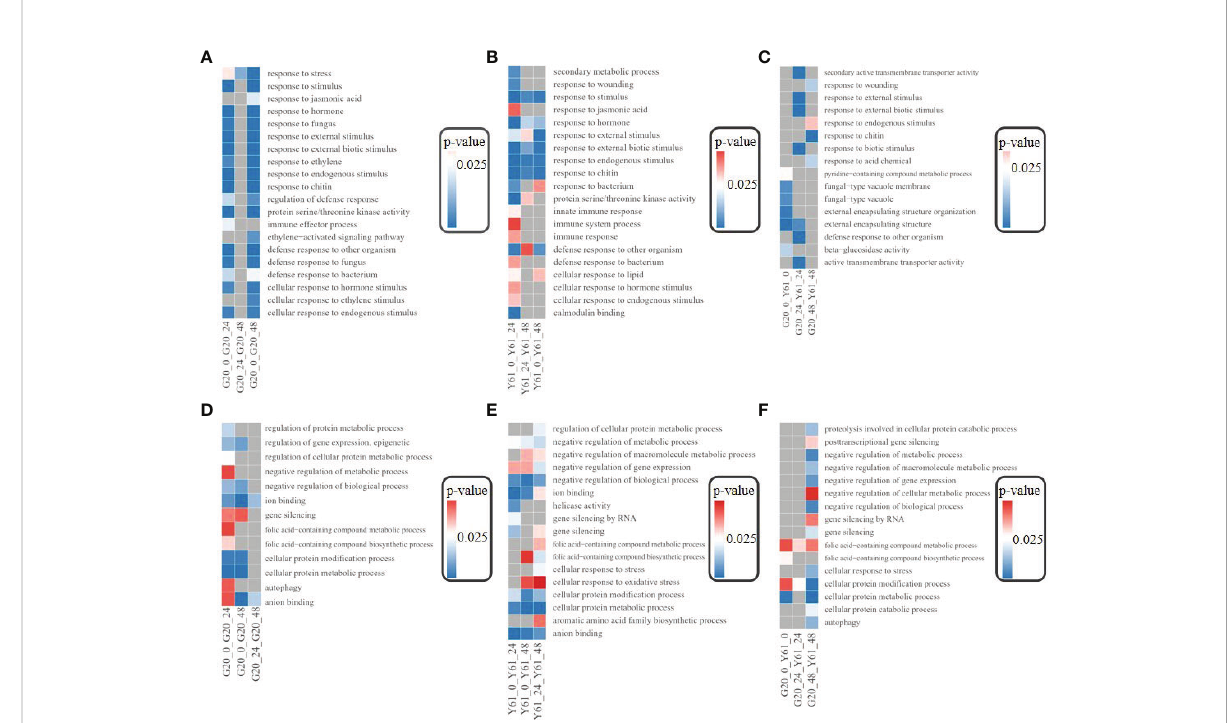
FIGURE 6 Results of GO enrichment analysis of DEGs. (A) , GO terms for the enrichment of DEGs in G20; (B) , GO terms for the enrichment of DEGs in Y61; (C) , GO terms for the enrichment of DEGs between G20 and Y61 at different time points; (D) , GO terms for the enrichment of target genes for DElncRNAs in G20; (E) , GO terms for the enrichment of target genes for DElncRNAs in Y61; (F) , GO terms for the enrichment of target genes for DElncRNAs between G20 and Y61 at different time